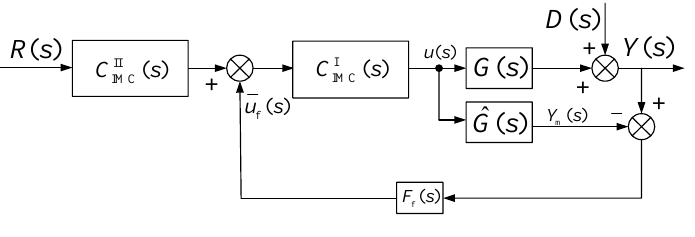
Figure 11. Block diagram of a 3-DOC-IMC.